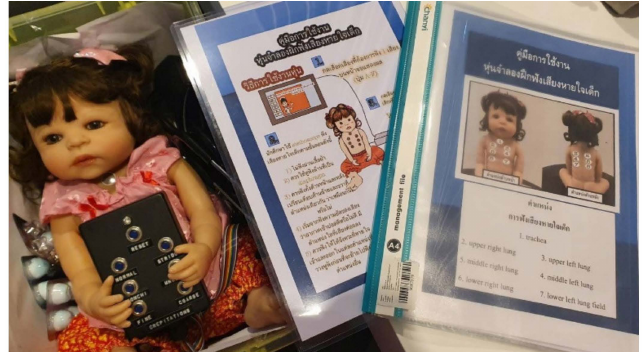
Figure 10. The CHIM and its instruction manual.